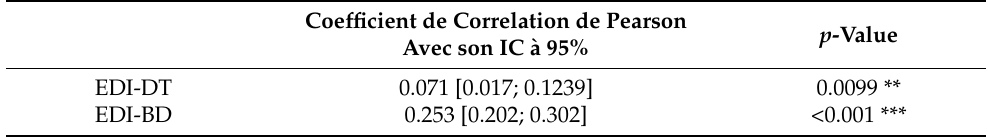
Table 8. Results of association between BMI and EDI scores.